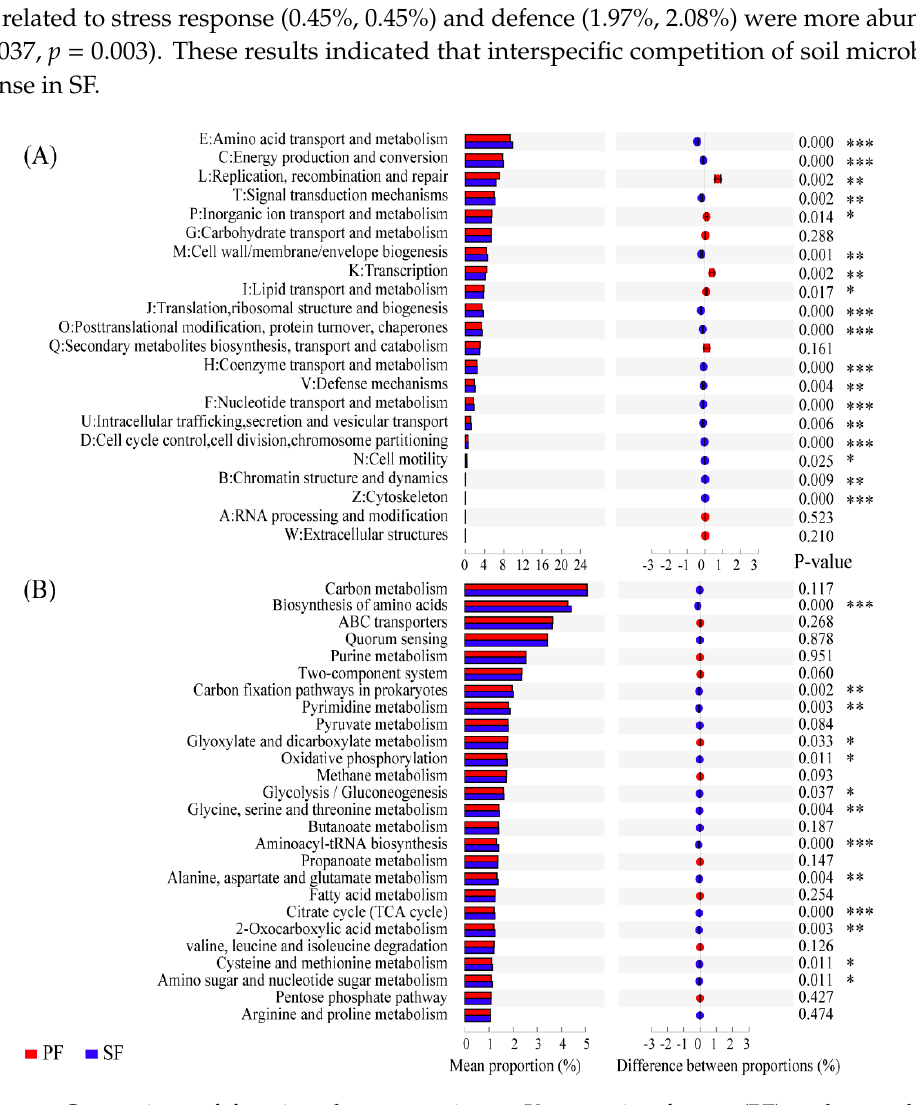
Figure 4. Comparison of functions between primary Korean pine forests (PF) and secondary broad ‐ leaved forests (SF) in the eggNOG and KEGG databases. ( A ) Functional categories of the eggNOG. ( B ) Metabolic pathways with relative abundance greater than 1% at the KEGG level ‐ 3. p < 0.05 denotes significant differences between the two forest types. p < 0.05 *, p < 0.01 **, p < 0.001 ***.